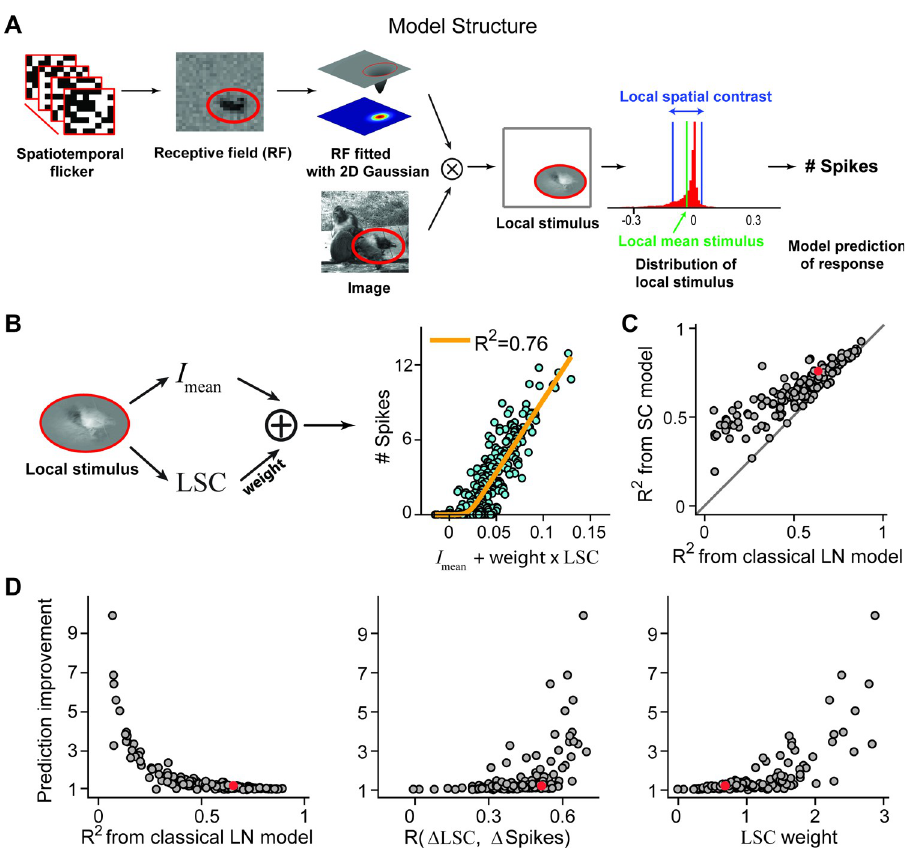
Fig 3. Modeling responses to natural images based on simple image statistics. A) Model for assessing the effect of simple image statistics on the spike count. Stimulation with spatiotemporal flicker is used to calculate a ganglion cell’s spatial receptive field, which is then fitted by a 2D Gaussian function. Each natural image is cropped to the 3-sigma contour of the receptive field (red line) and weighted by the 2D Gaussian, yielding the local stimulus. The mean stimulus intensity ( I mean ) and the local spatial contrast (LSC) are obtained as the mean and the standard deviation of the pixel intensities in this local stimulus. Both measures are used in the prediction of the spike count response. B) Left: Schematic depiction of the SC model, which uses a weighted sum of the extracted values of I mean and the LSC for a given image. Right: Relationship between the linear signal of the SC model and the number of spikes recorded from the sample cell of Fig 2 for all images. The orange line shows the fitted nonlinearity, with the stated R 2 value used as an evaluation of the quality of the fit. C) Coefficients of determination R 2 compared for the classical LN model, which takes only I mean as input, and the SC model, which takes into account both I mean and LSC, for all cells (N = 156). D) Relative prediction improvement of the SC model over the classical LN model (computed as the SC model performance normalized by the LN model performance) vs. model performance of the classical LN model (left), vs. the correlation coefficients calculated from Δ LSC and Δ Spikes (center), and vs. the optimal LSC weights found in the fit of the SC model. The sample cell is marked in red in C and